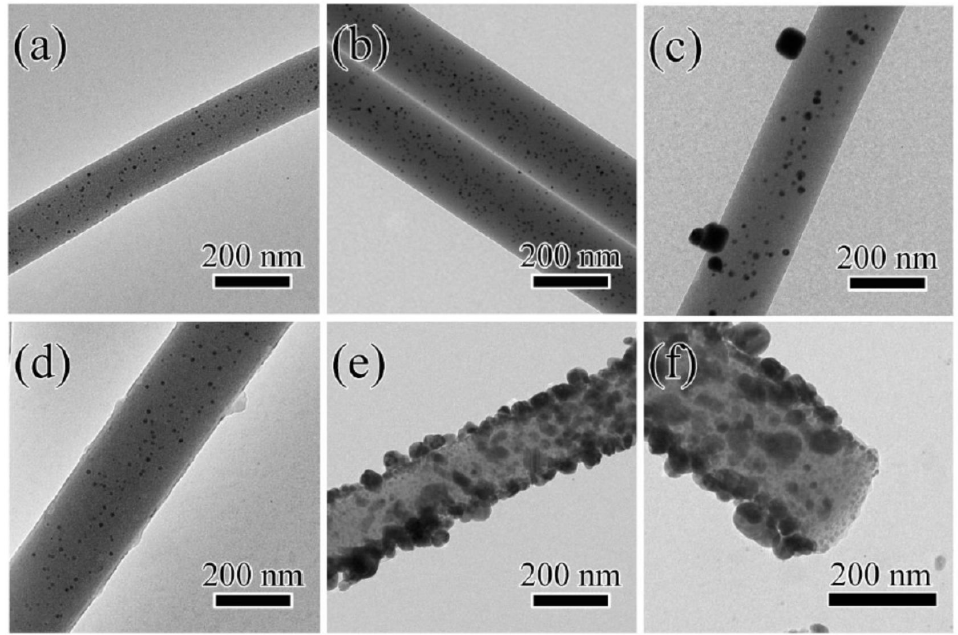
Figure 3. TEM images of SiO 2 @Au-10 ( a ), SiO 2 @Au-20 ( b ), SiO 2 @Au-30 ( c ), T-A@SiO 2 @Au-20 ( d